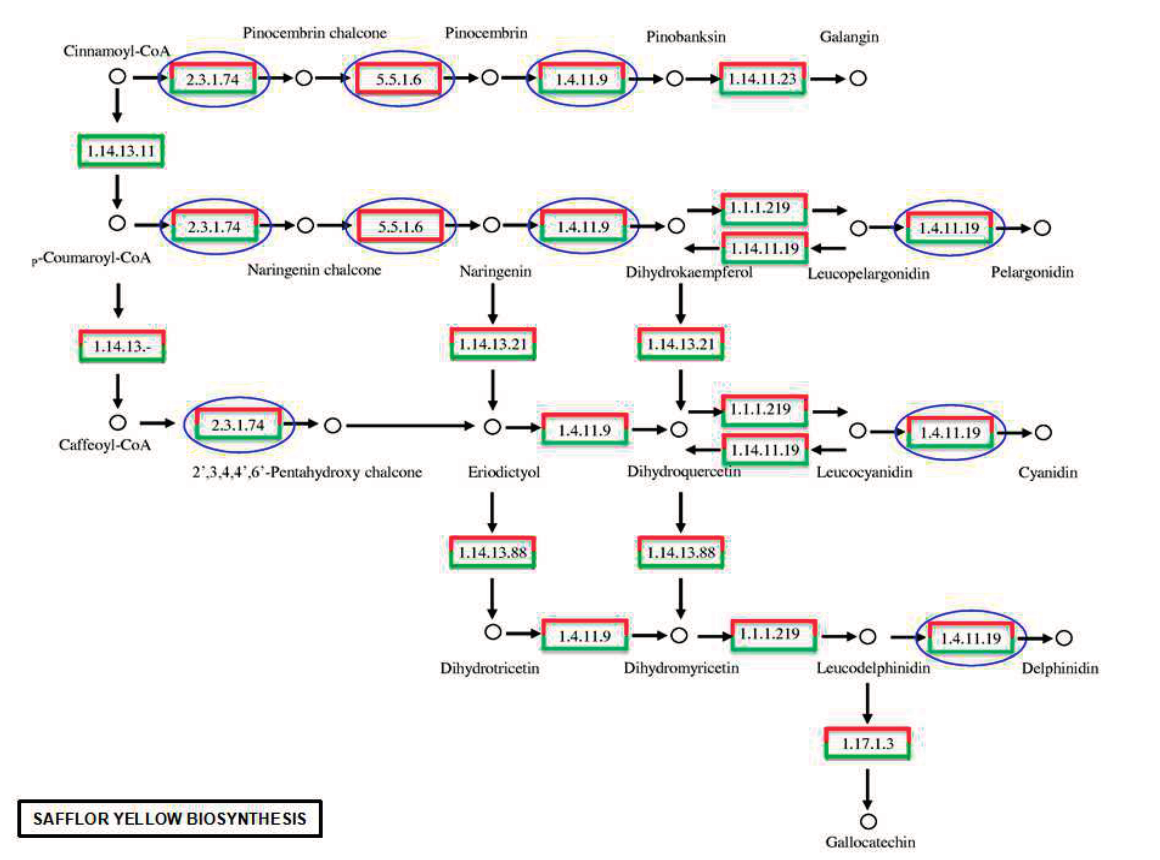
Figure 9. The metabolic pathways for safflor yellow biosynthesis. Blue circles indicate the important enzymes that were focused on in flavonoid biosynthesis. The red boxes represent up-regulation, and the green boxes represent